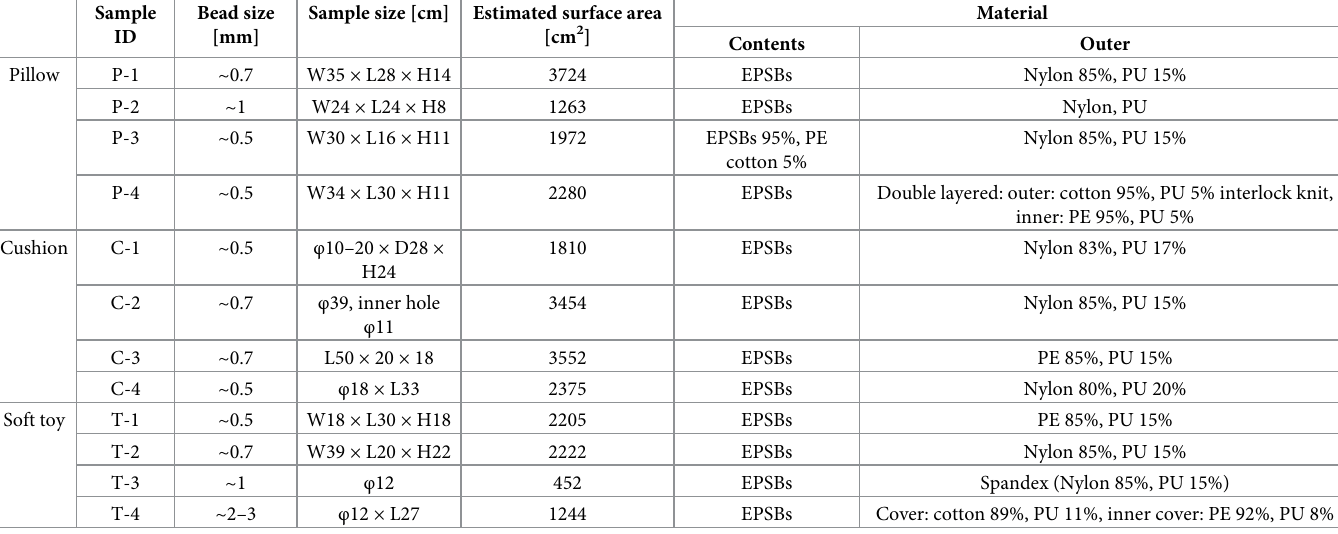
Table 1. Information on the samples of products containing expanded polystyrene beads